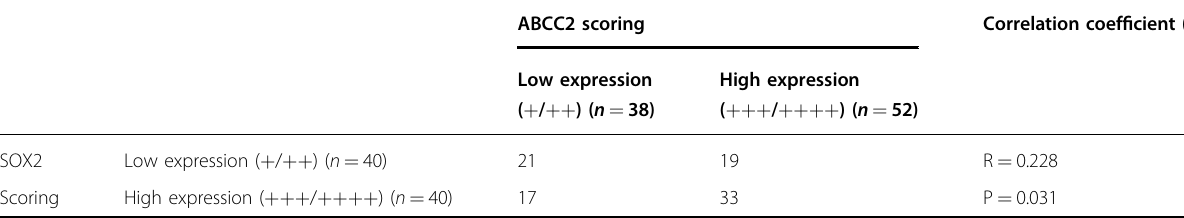
Table 1 Correlation between SOX2 and ABCC2 expression in CRC